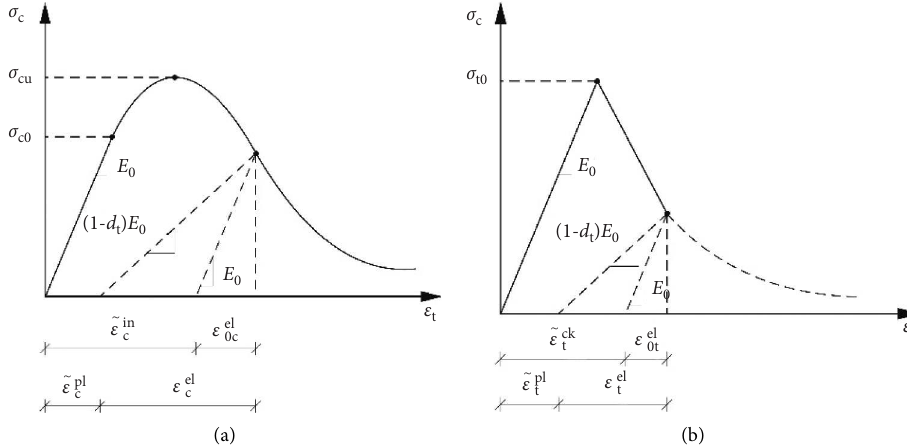
Figure 7: Damage development in compression and tension. (a) Compression damage. (b) Tension damage.